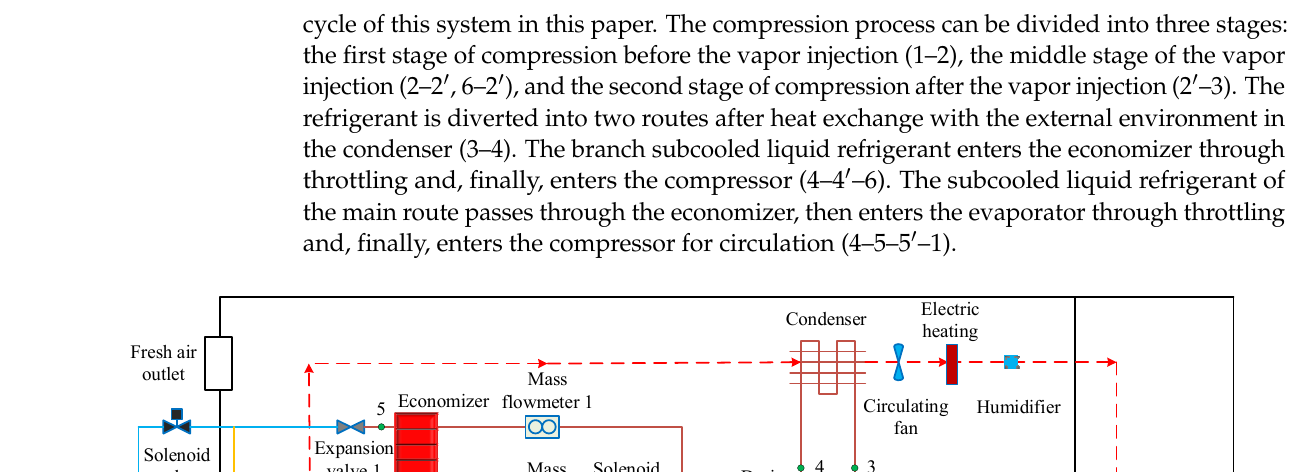
Figure 1. Schematic diagram of the heat-pump drying system with double evaporator.